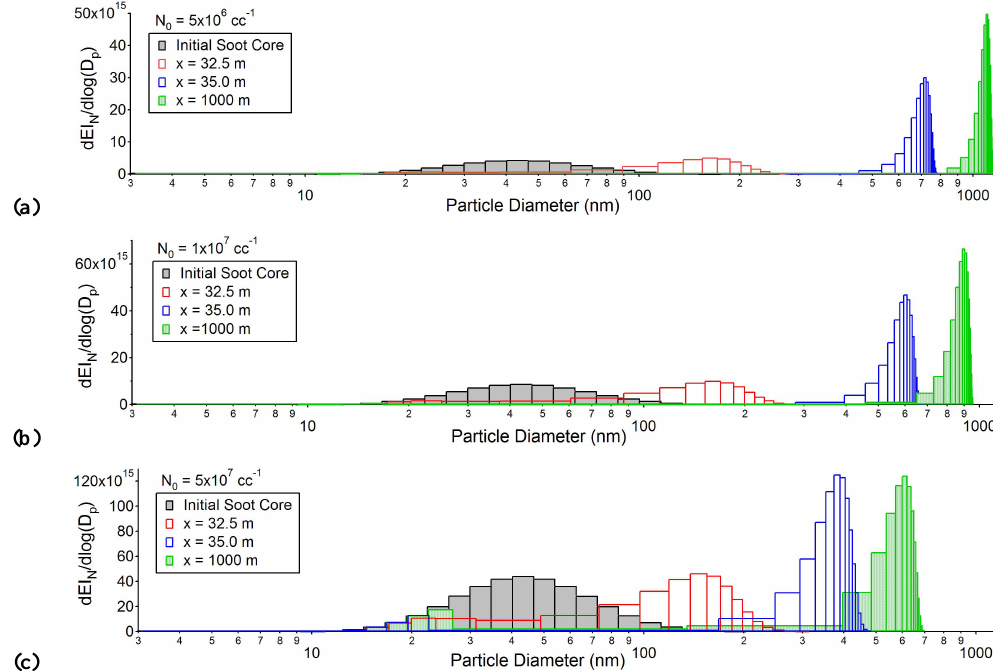
Fig. 7. Effects of initial soot core number concentration ( N 0 ) on size distributions of ice coated soot particles as a function of downstream distance ( x ) when N 0 is: (a) 5 × 10 6 cc − 1 (EI N ∼ 2.3 × 10 15 (kg-fuel) − 1 ) ; (b) 1 × 10 7 cc − 1 (EI N ∼ 4.6 × 10 15 (kg-fuel) − 1 ) ; (c) 5 × 10 7 cc − 1 (EI N ∼ 2.3 × 10 16 (kg-fuel) − 1 )